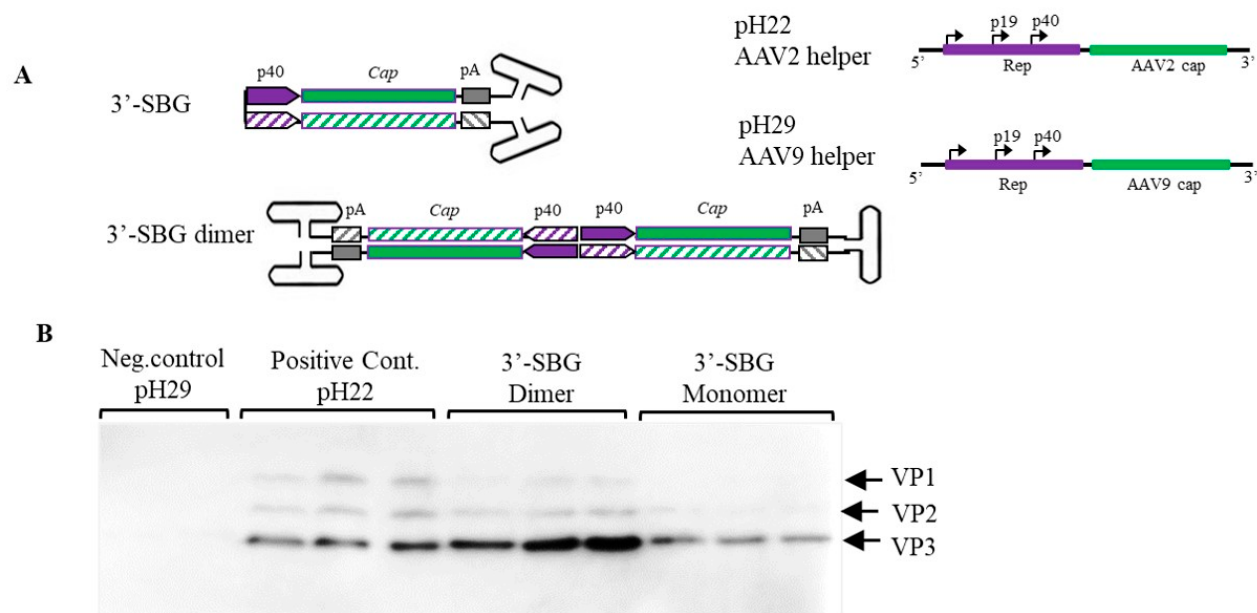
Figure 3. Enhancement of Cap protein expression by 3 ′ -SBG. ( A ). 3 ′ -SBG is shown in monomer configuration; 3 ′ -SBG dimer is the extended form of 3 ′ -SBG after 2nd stranded DNA synthesis or replication. ( B ). Effects of 3 ′ -SBG on capsid protein expression. AAV 3 ′ -SBG molecule dimer was modeled by intermolecular ligation of a SamI and BamHI digestion fragment from the AAV infectious clone psub201. AAV 3 ′ -SBG monomer was modeled by an intramolecular ligation of the same SamI and BamHI digestion fragment. Cap protein expres- sion was detected with mouse anti-AAV Capsid antibody by western blotting at 72 h post transfection. pH29 negative: HEK 293 cells were transfected with pF Δ 6 and pH29 mutation plasmid without AAV2 capsid ex- pression; pH22: HEK 293 cells were transfected with pF Δ 6 and pH22 plasmid which express AAV capsid; AAV 3-SBG dimer: HEK 293 cells were transfected with pF Δ 6 and 3-SBG dimer molecules; AAV 3-SBG dimer: HEK 293 cells were transfected with pF Δ 6 and 3-SBG monomer molecules. Each condition is shown as tripli- cate.